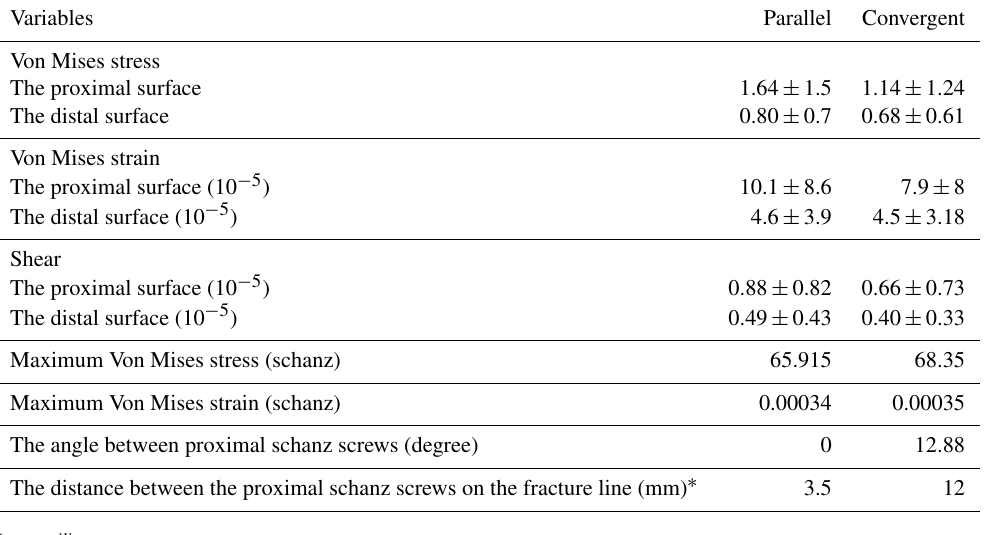
Table 2. The biomechanical parameters at the fracture line.